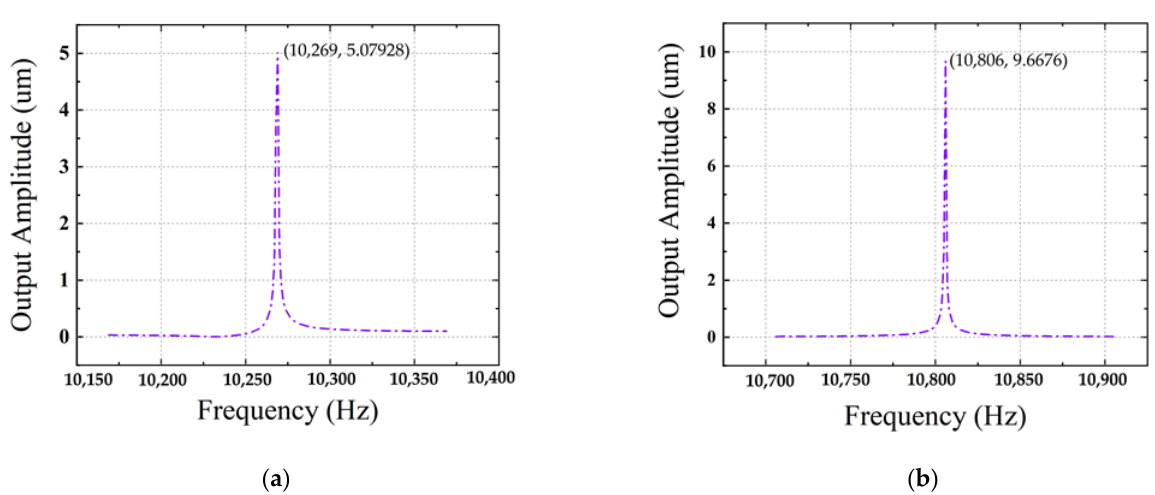
Figure 3. ( a ) Drive mode frequency domain. ( b ) Sense mode frequency domain.